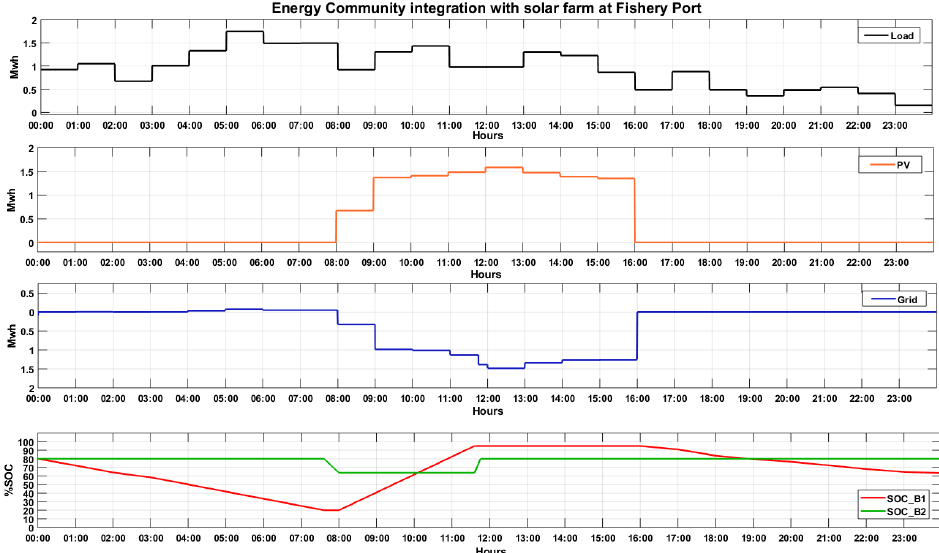
Figure 10. Simulation results for the expanded energy community.